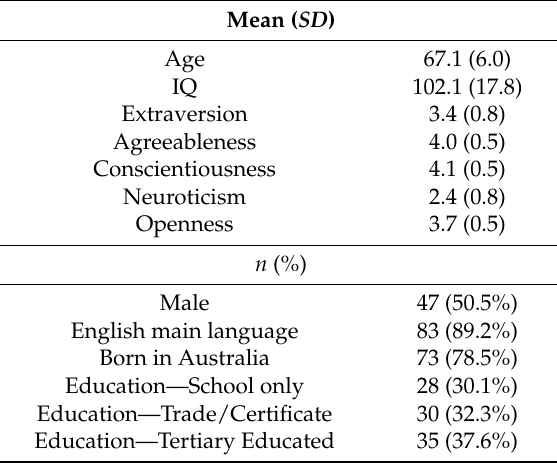
Table 1. Sample characteristics and mean personality